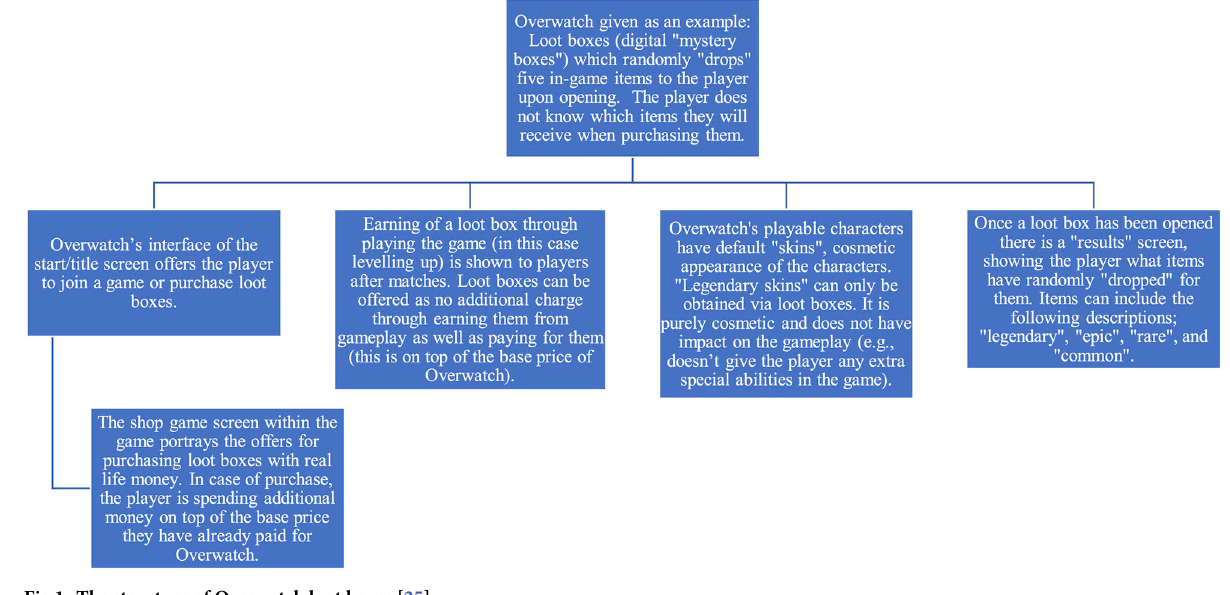
Fig 1. The structure of Overwatch loot boxes